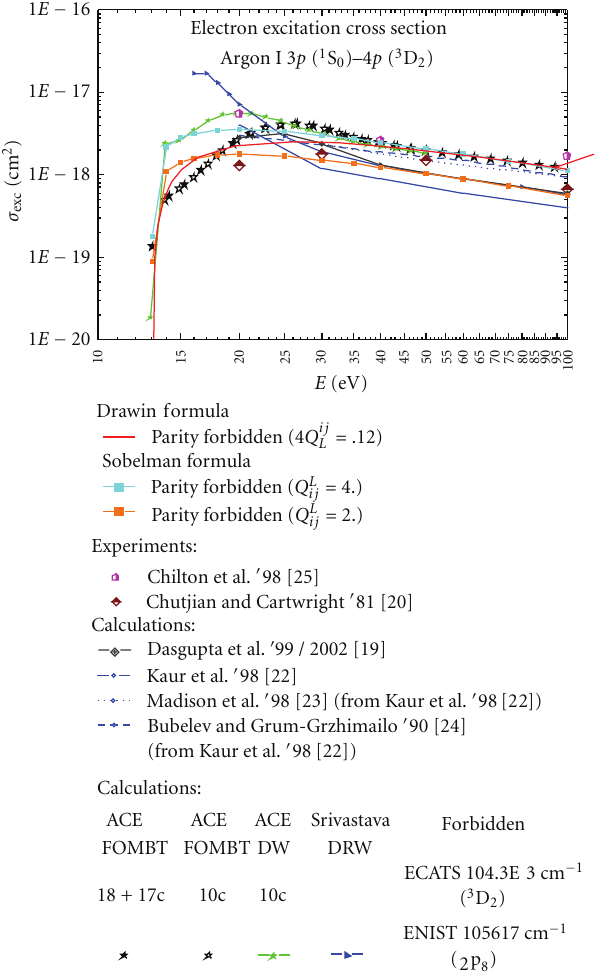
of Bo ff ard et al. [30, 31] and one of Piech et al. [32] are in